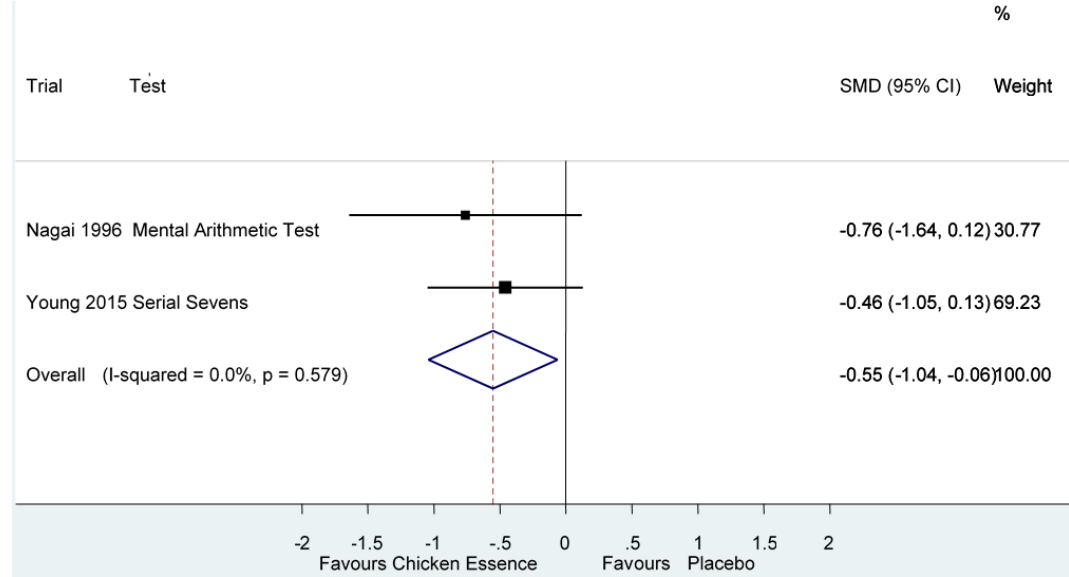
Figure C1. Pooled effect estimate of score of error and error rate of executive function tests. SMD, Standardized mean difference; CI, Confidence interval.